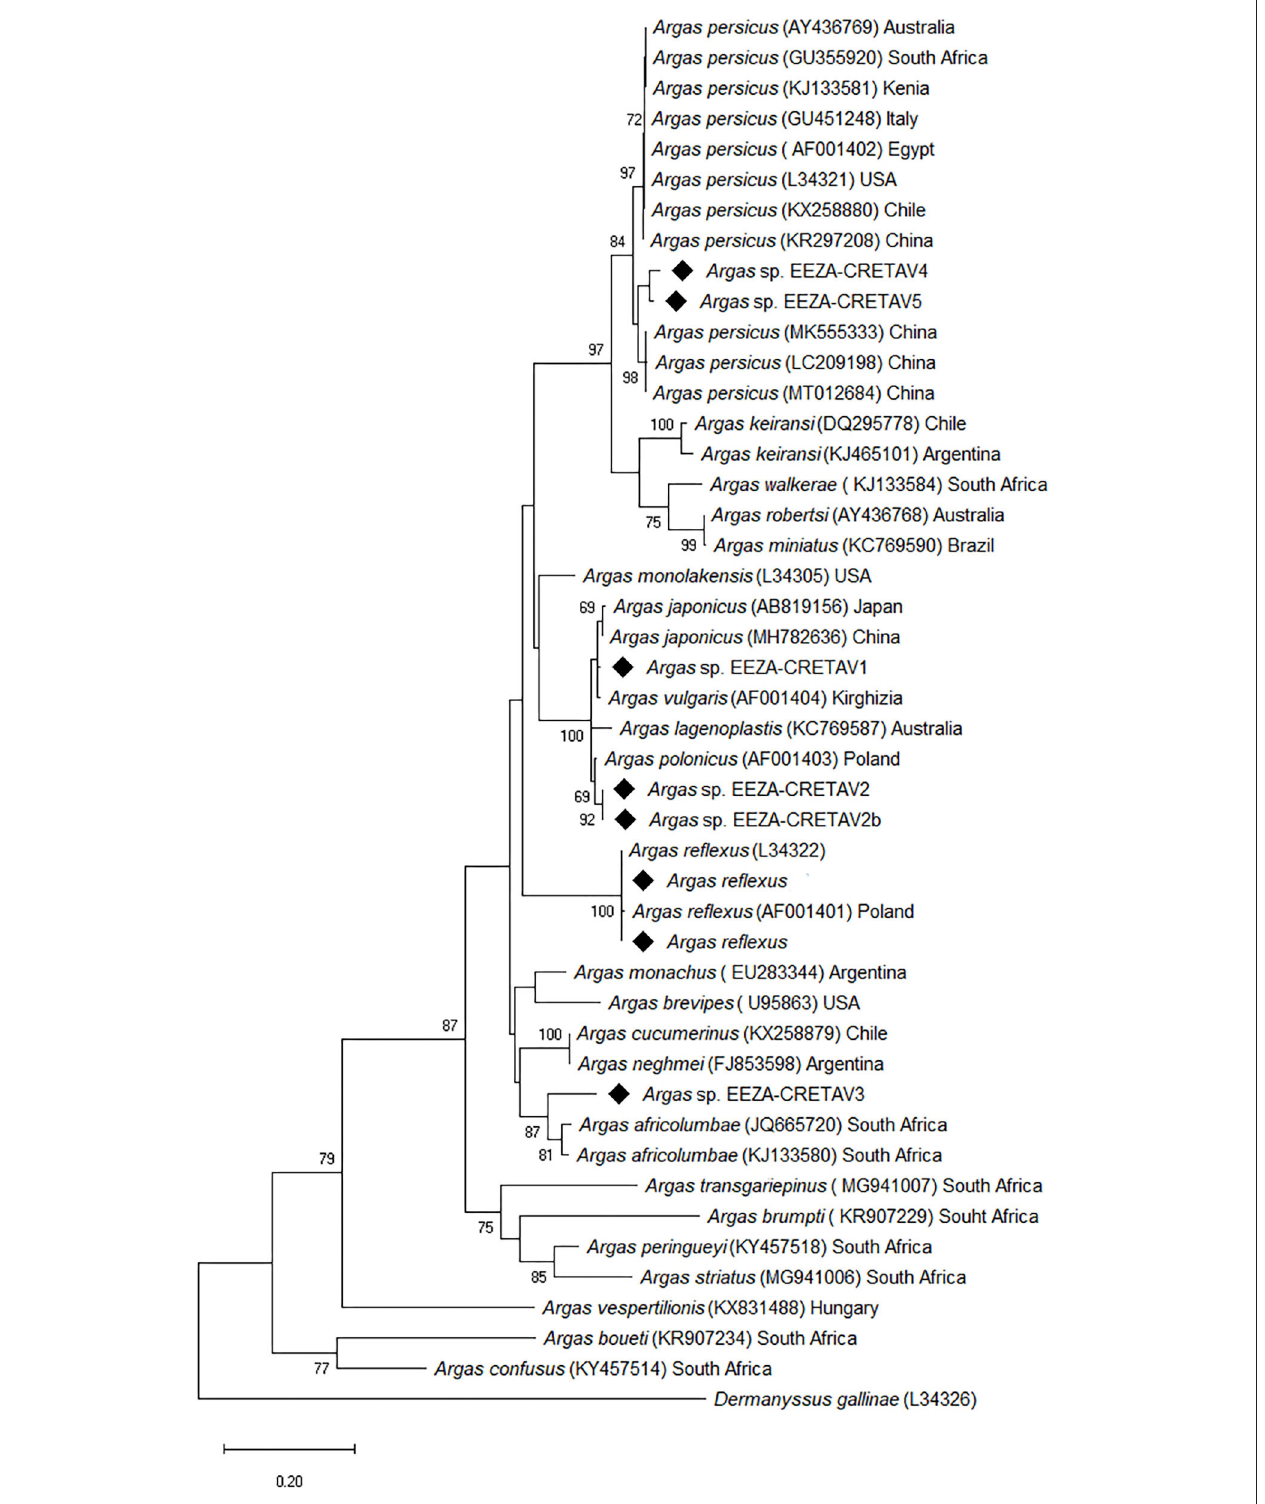
FIGURE 1 | Phylogenetic tree based on 16S rRNA analysis showing the relationships between tick species and genotypes identified in this study and published validated Argas species. The evolutionary analysis was inferred using the maximum likelihood method and general time reversible + G model with Mega X.